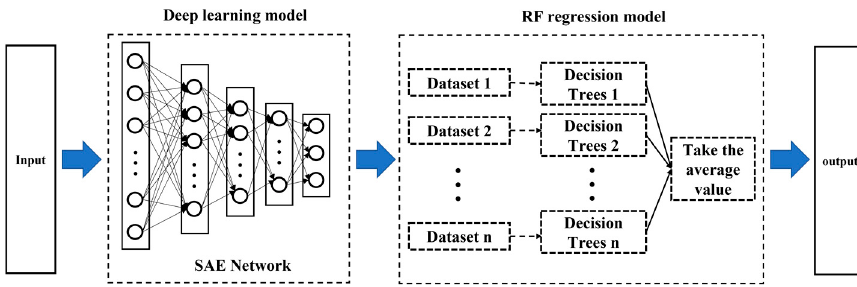
Figure 4. SAE-RF-based soft sensor model.